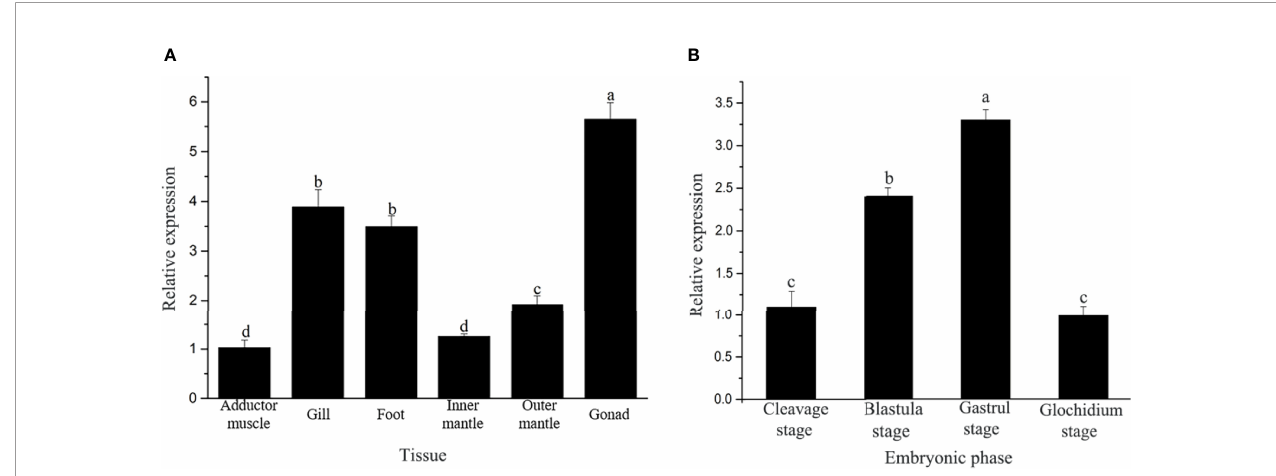
FIGURE 4 | (A) Analysis of relative Hc-CDK6 expression levels in different tissues. (B) Hc-CDK6 expression levels during different embryonic periods. Values with different letters indicate P <